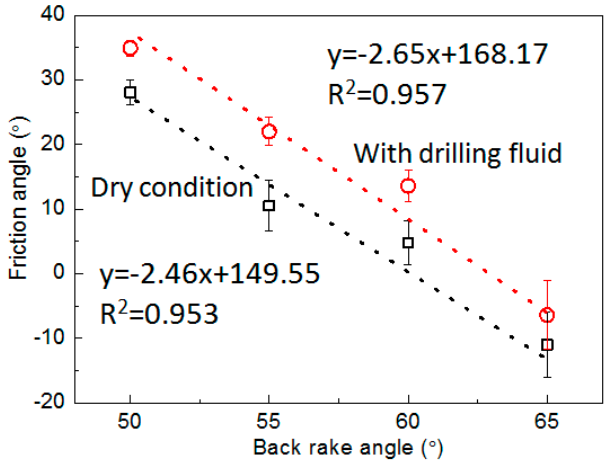
Figure 5. Variation of friction angle with back rake angle in dry condition and drilling fluid environment.